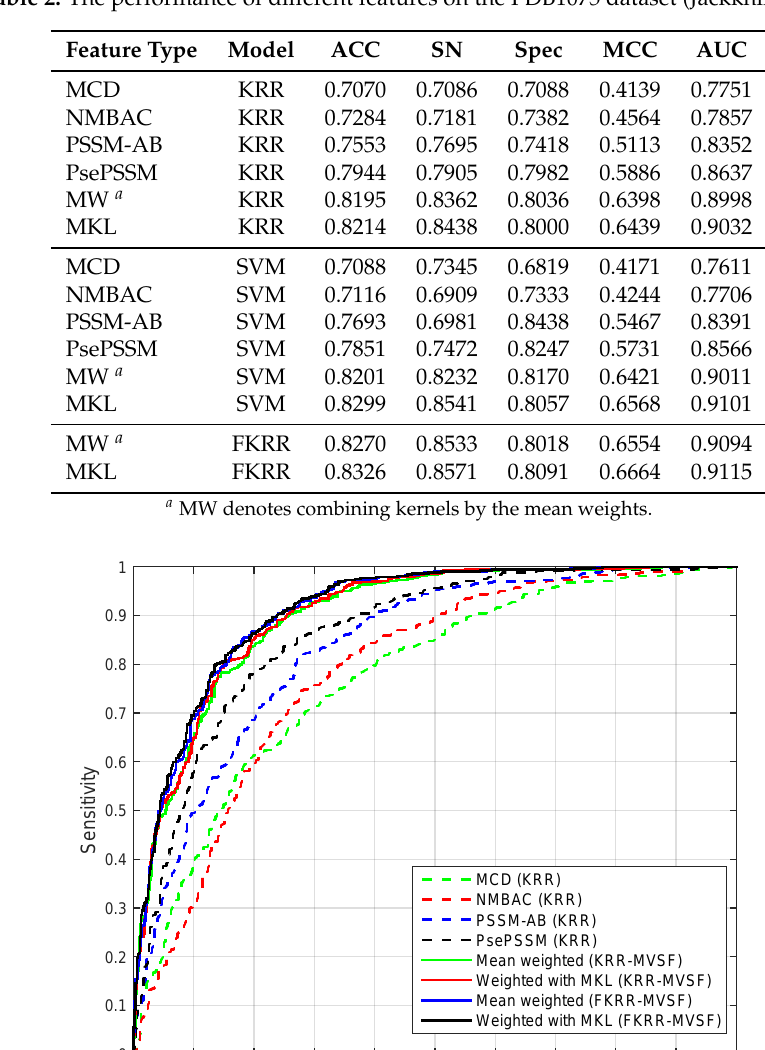
Table 2. The performance of different features on the PDB1075 dataset (Jackknife test).